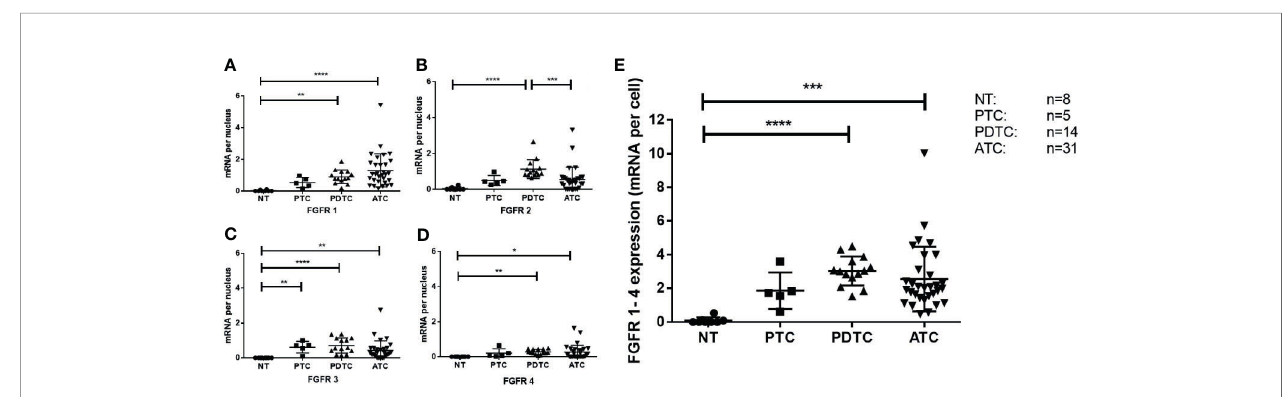
FIGURE 4 | FGFR expression in ATC, PDTC, PTC and NT. FGFR1 (A) , FGFR2 (B) , FGFR3 (C) and FGFR4 (D) was detected at low levels in all samples studied. Signi fi cant differences are indicated. Combined scoring of FGFR1-4 expression in ATC and PDTC (E) is signi fi cantly higher compared to normal thyroid (NT) tissue. *p < 0.1, **p < 0.01, ***p < 0.001, ****p <